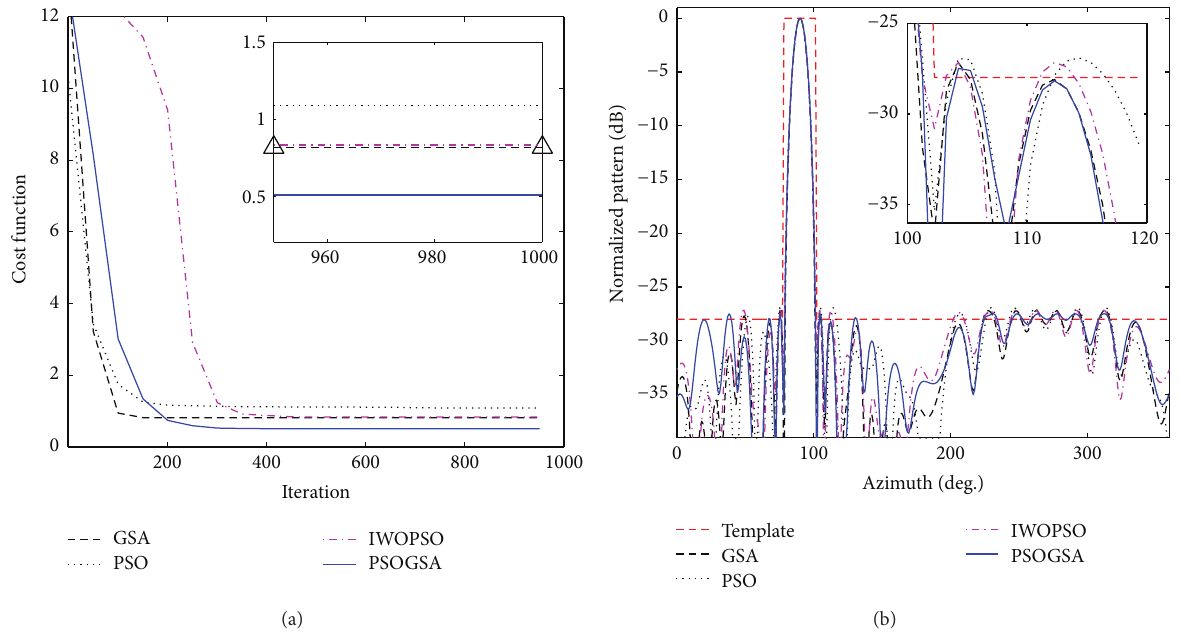
Figure 7: (a) Cost function versus iteration times. (b) Radiation pattern for half-circle array.